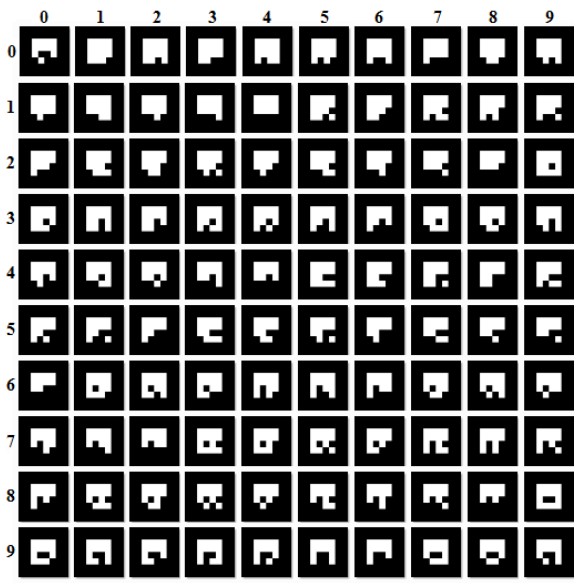
Fig. 2. Investigated markers and their corresponding ID = (row nr.; column